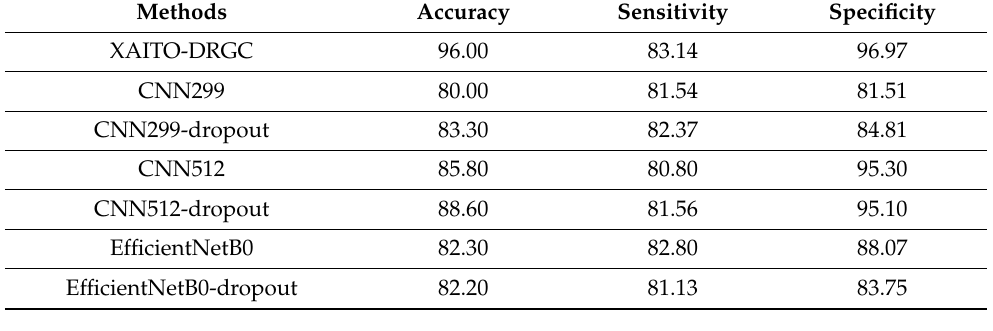
Table 3. Comparative analysis of the XAITO-DRGC approach with recent methods on the APTOS 2019 dataset.